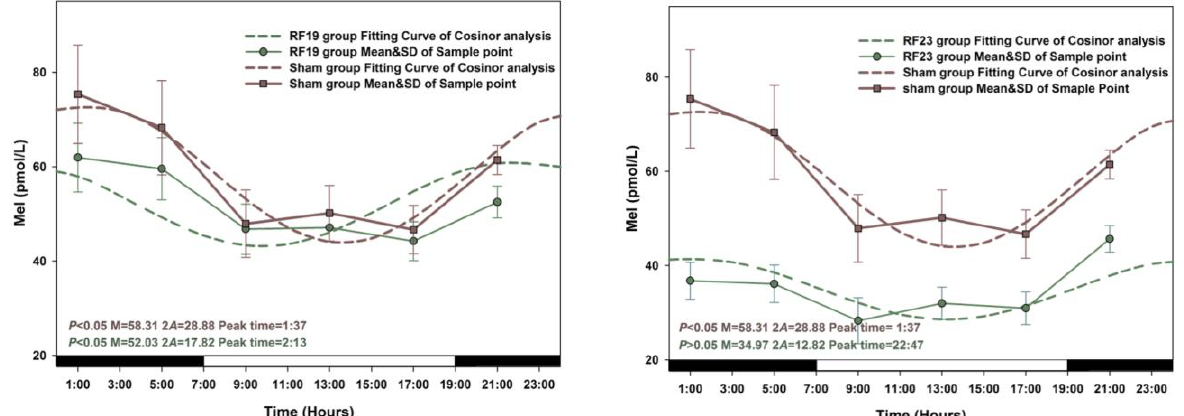
Figure 4. The best-fitting curves (means ± standard error) determined for Mel in RF and Sham-exposed rats. Y-axis represents Mel concentration in the plasma; x-axis represents the Time during the 24 h light-dark cycle. For time-effect, p values from Zero-amplitude test, as well as the median (M), the double amplitude (2A) and the time of peak phase (Peak time) of the 24 h cosine curves, are listed. The circadian rhythm is regarded as significant when p <